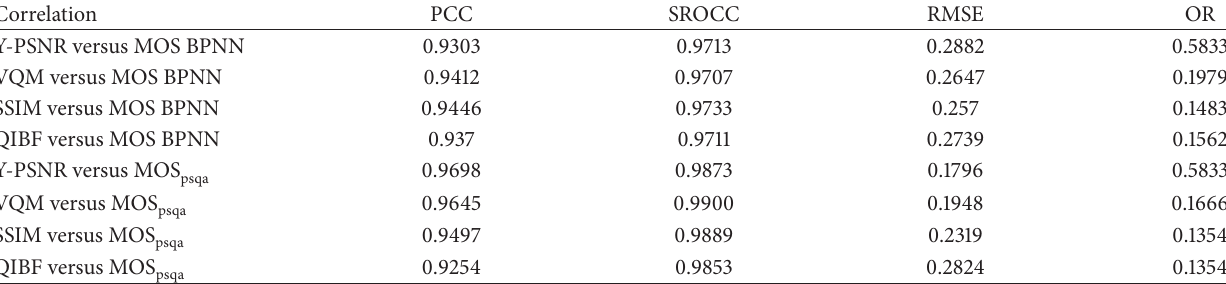
Table 6: General overview of the correlations obtained for the study